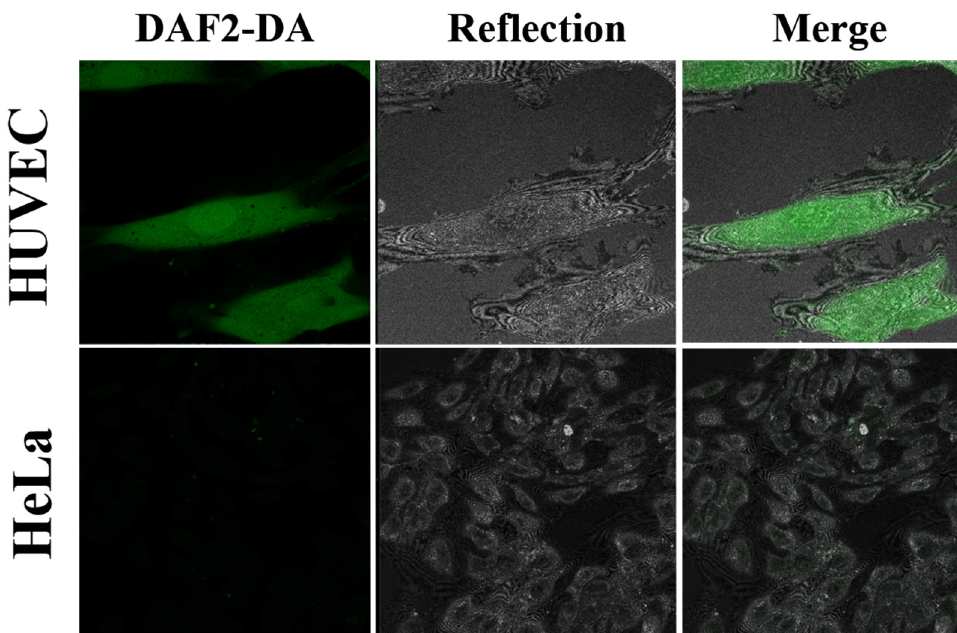
Figure 6. Representative CLSM images of HUVEC and HeLa cells of intracellular NO detection by the DAF2-DA using a standard protocol (10 µ M) in fluorescent, reflected mode, and merged. Confocal laser scanning microscopes (CLSM) with a water immersion objective Zeiss 40 × /NA 1.2 were applied.